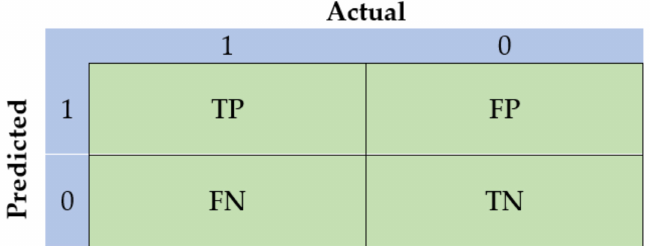
Figure 4. Representative illustration of a simplified confusion matrix.